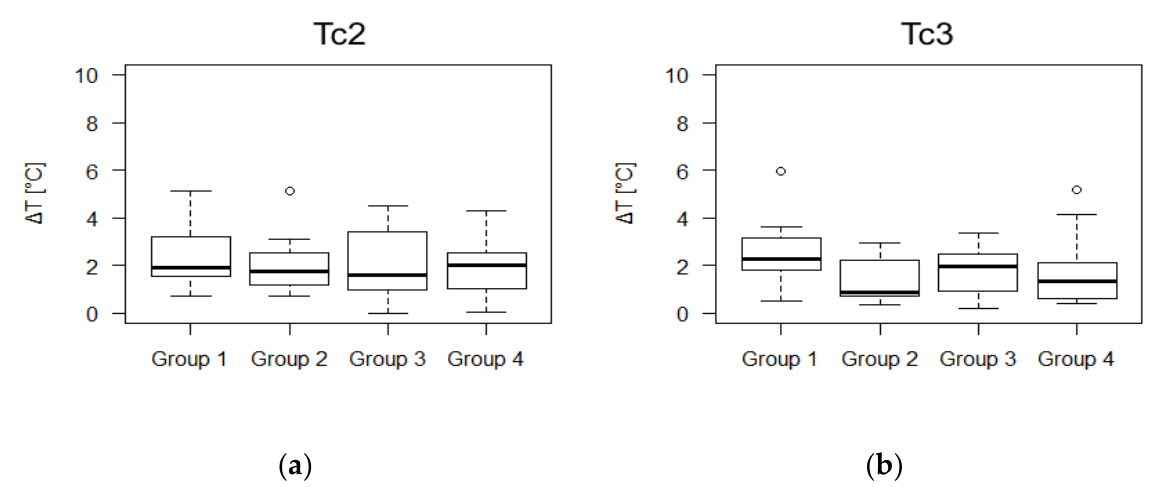
Figure 5. Boxplot showing the largest temperature variation ( ∆ T) at Tc1 in the four groups.